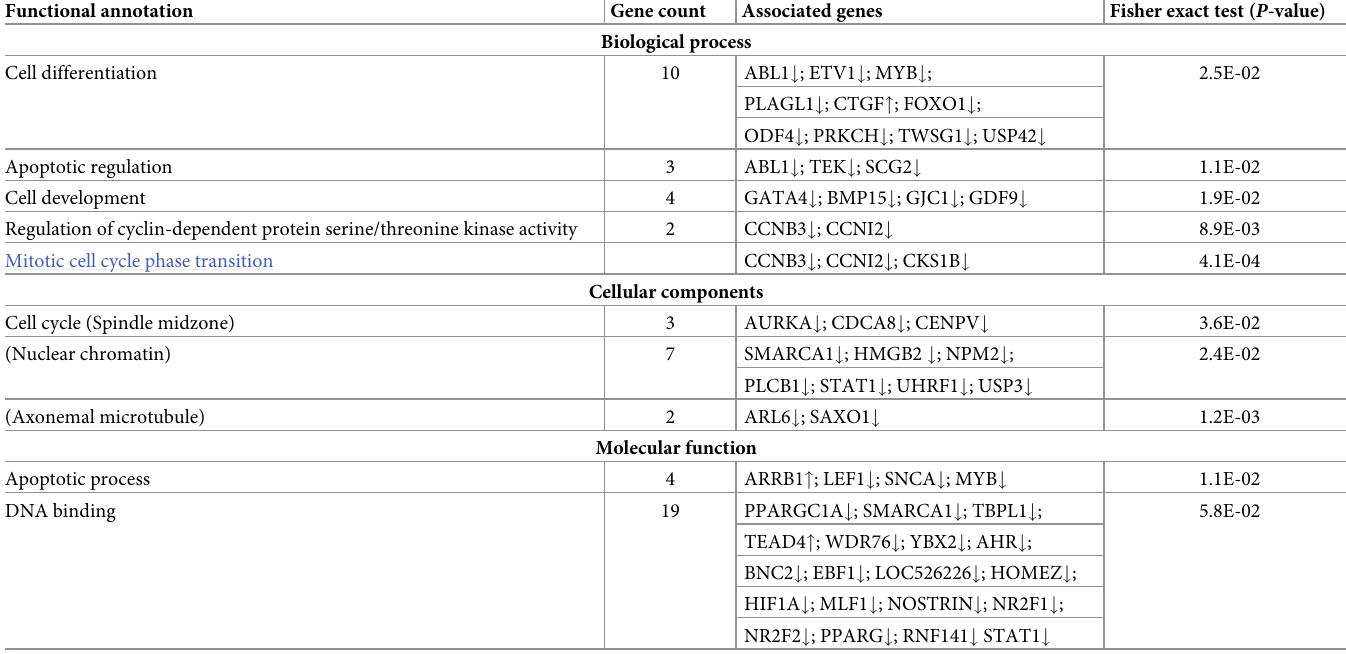
Table 4. Enrichment analysis of overlapping genes in blastocysts that developed from synchronously and asynchronously cleaved embryos that are differentially expressed in directly cleaved embryos